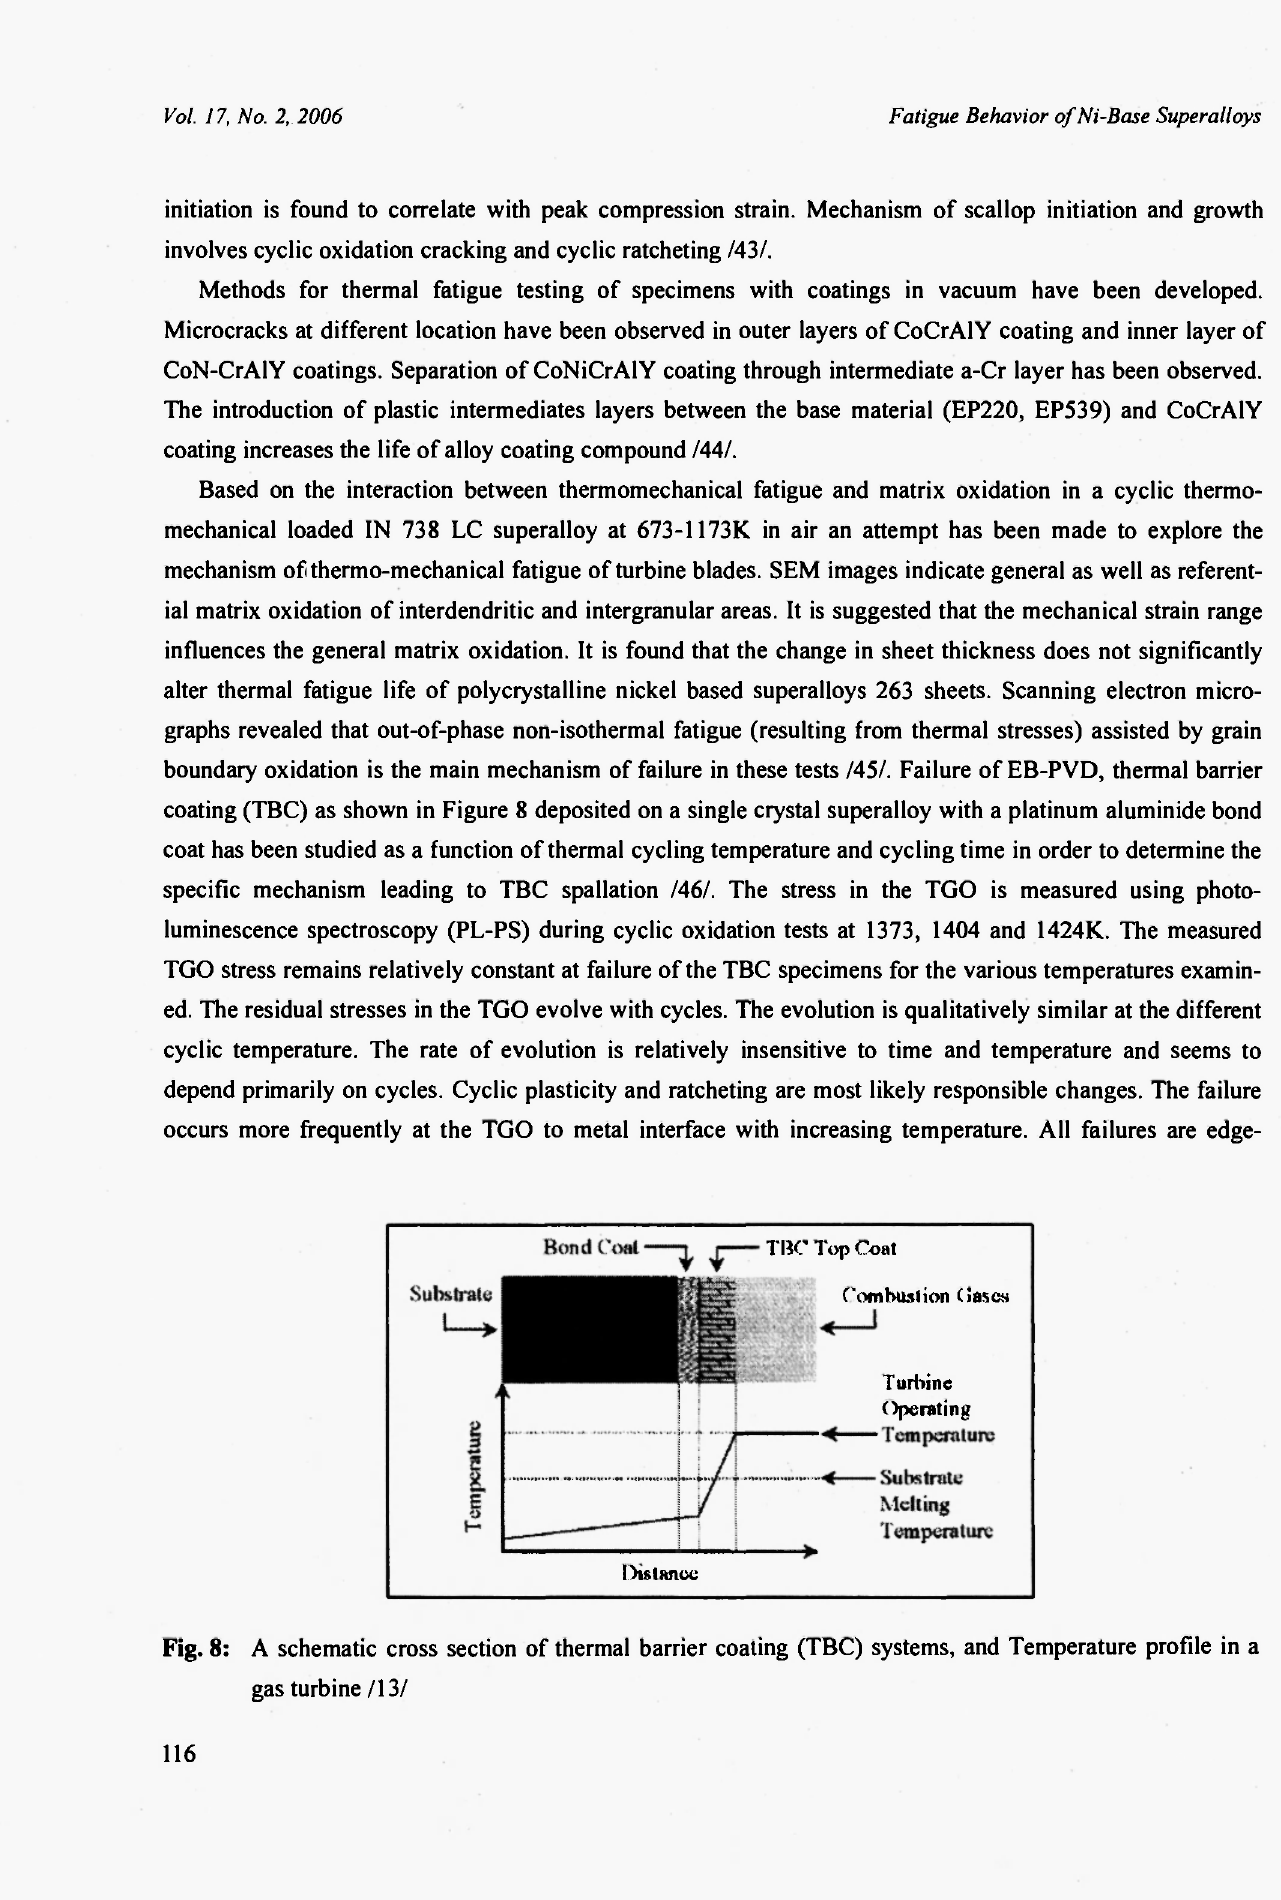
A schematic cross section of thermal barrier coating (TBC) systems, and Temperature profile in a gas turbine